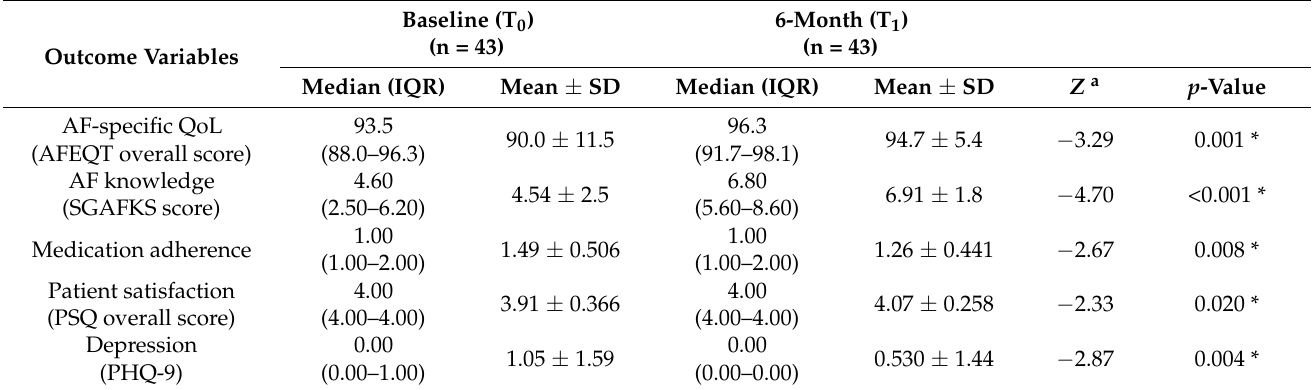
Table 4. Patient-reported outcomes at baseline and 6-month